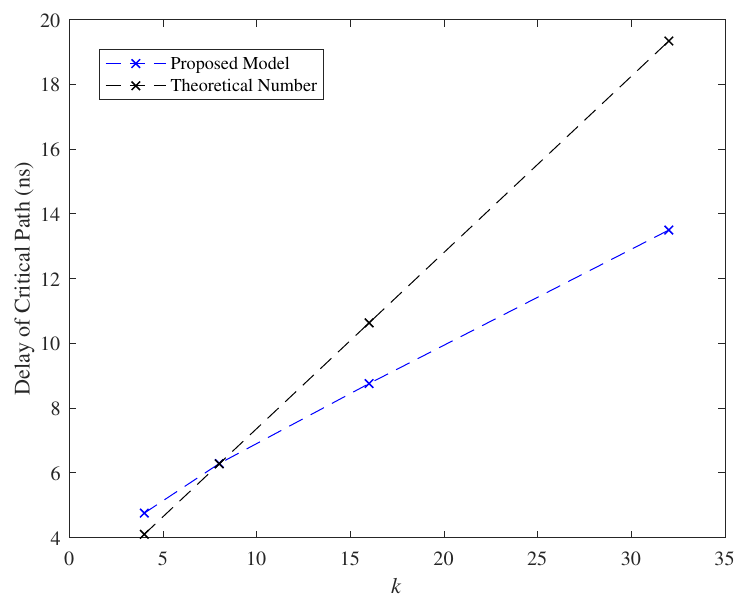
Figure 17. Effect of the parameter k with respect to the delay of critical path.